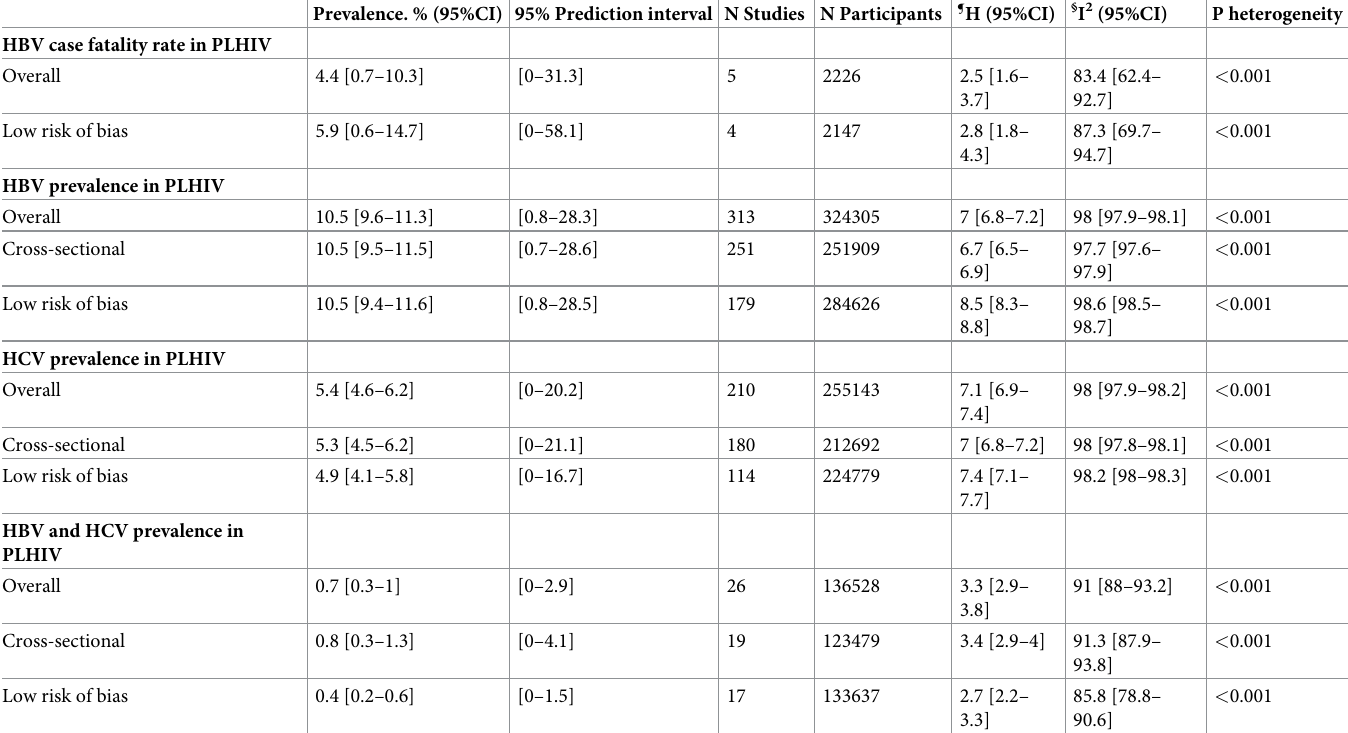
Table 1. Summary of meta-analysis results for epidemiology of hepatitis B and C in people living with HIV in